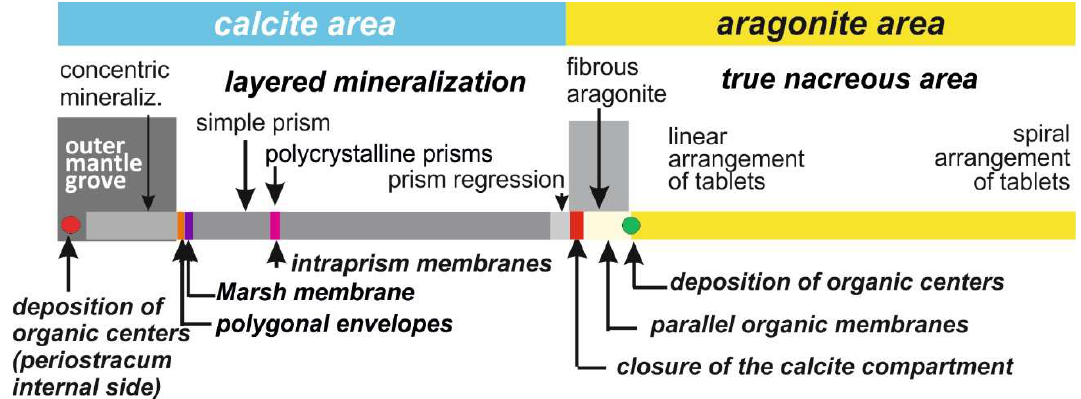
Figure 10. Sequence of the organic structures acting during Pinctada shell development.